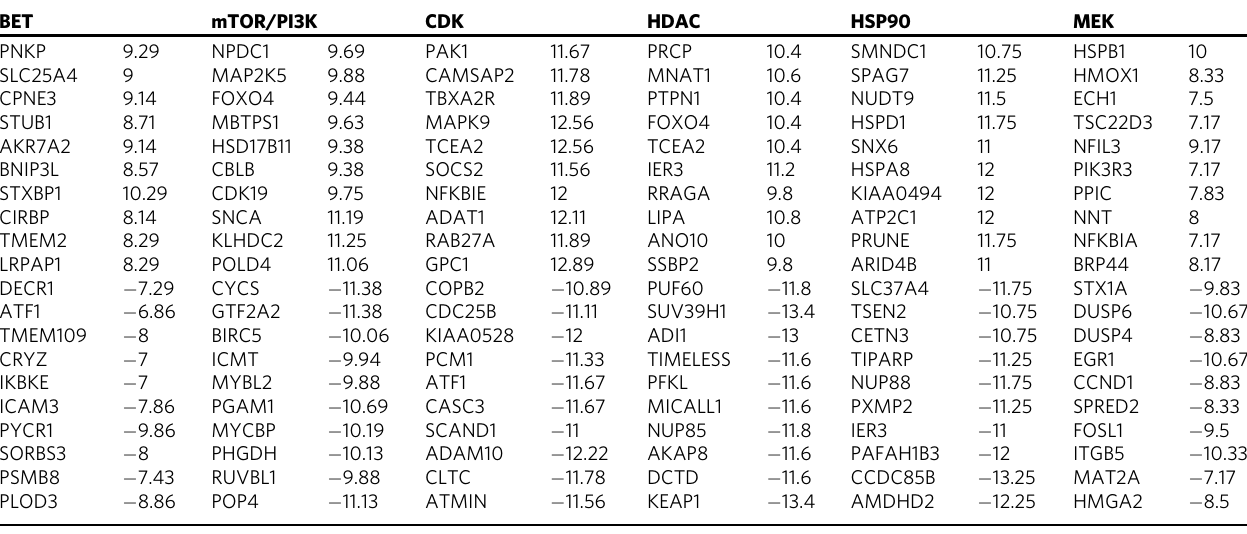
Table 1 Top 10 upregulated (top) and top 10 downregulated (bottom) L1000 genes with expression levels from mechanism of action networks in Fig.